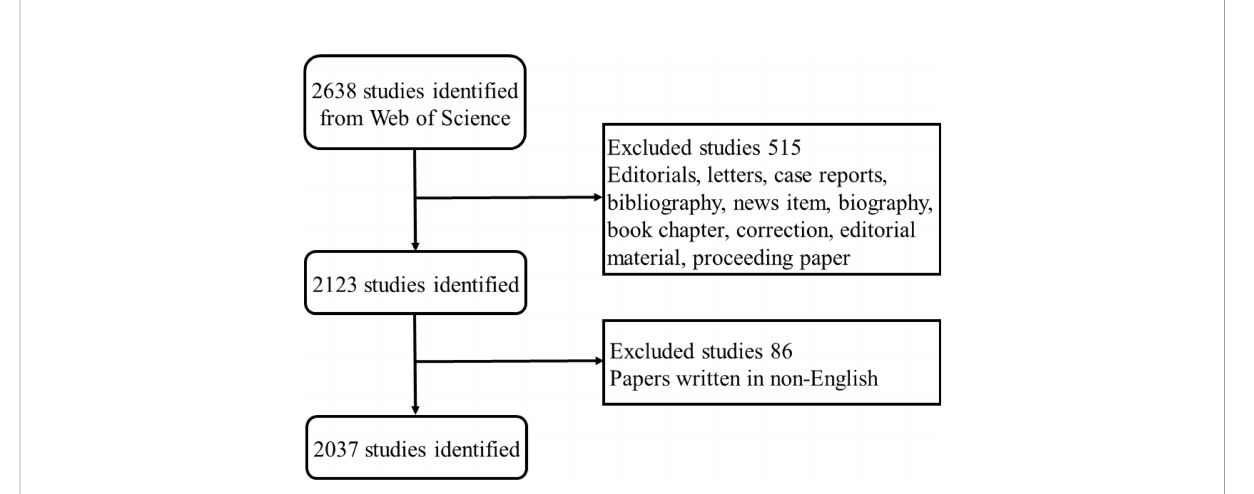
FIGURE 1 Flow diagram of the bibliographic retrieval process. The procedures of screening and enrollment are presented in